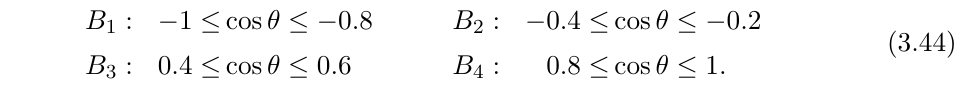
(cid:22) (cid:22) production in the m !